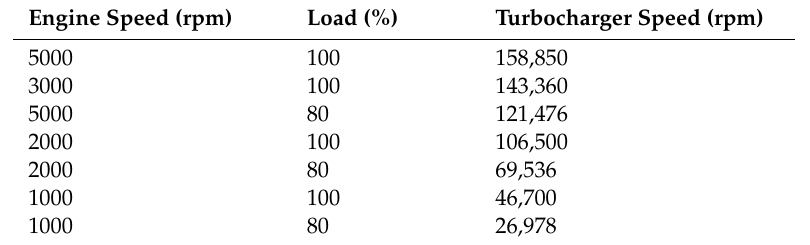
Table 10. Turbocharger shaft speed based on engine model operating conditions for map generation.